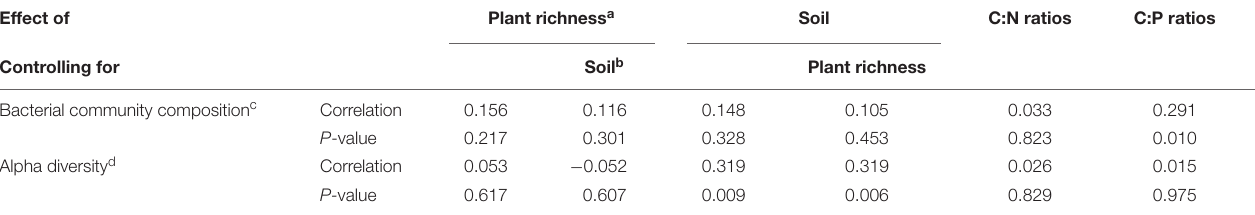
TABLE 3 | Influence of plant richness and soil properties on bacterial community composition and alpha diversity by partial Mantel test. Effect of Plant richness a Soil C:N ratios C:P ratios